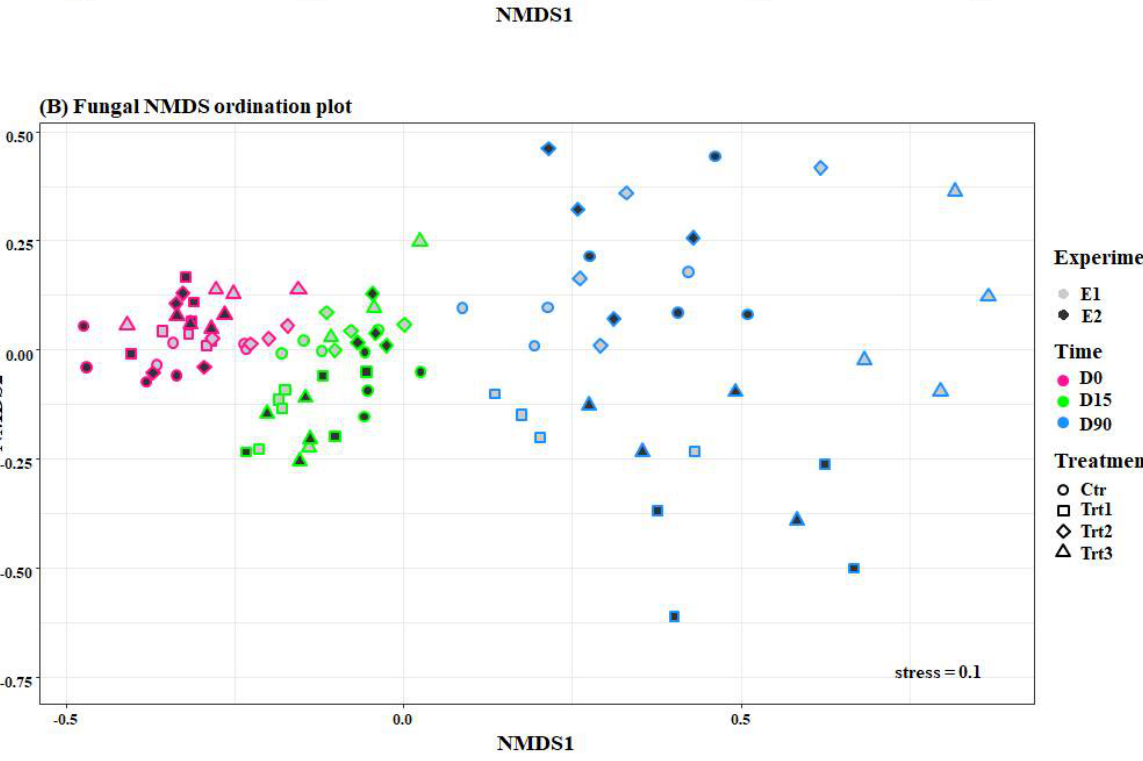
Figure 4. Ordination plots of non-metric multidimensional scale analysis (NMDS) using the Bray-Curtis dissimilarities of bacterial ( A ) and fungal ( B ) communities. Pink, green, and blue colors indicate different sampling times (D0: after 12 h; D15: after 15 days; D90: after 90 days) and show how both fungal and bacterial communities are grouped by time. The colors of the filling, grey and black, represent the two experiments (E1 and E2, respectively), and different shapes represent the treatments that grouped, mainly the bacterial community. Ctr: bulk soil; Trt1: soil with 10 g of beech wood pellets; Trt2: Trichoderma atroviride SC1 applied to the soil as a conidial suspension at the rate of 5 × 10 3 conidia g −1 of soil; Trt3: soil with 10 g of T. atroviride SC1 coated beech wood pellets at 5 × 10 5 conidia g −1 .